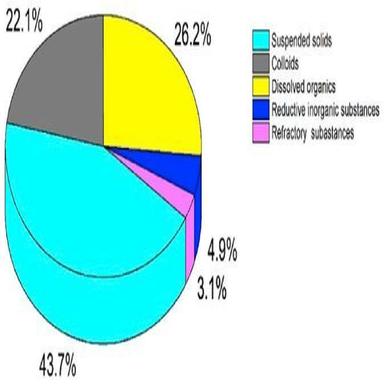
The proportion of COD contributed by suspended solids, colloids, dissolved organic substances and reductive inorganic substances in total COD of the BTCW.